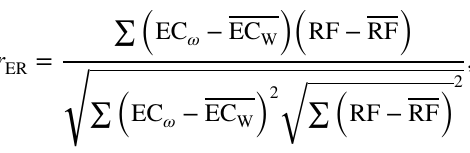
Table 1 The water yield factors of each city (area)